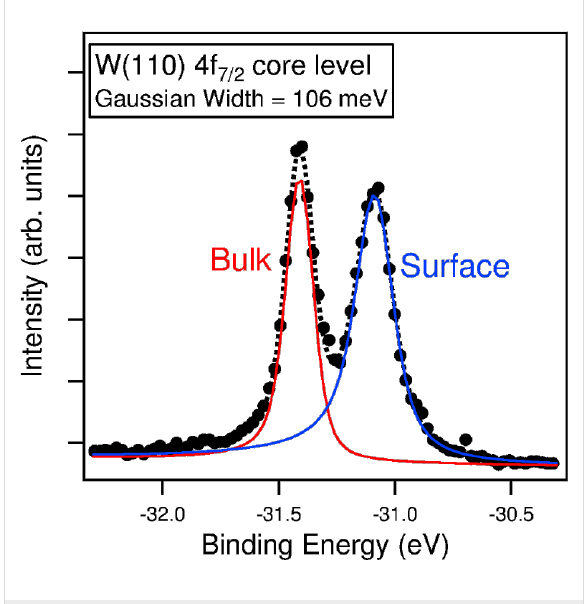
Figure 6: Tungsten 4f 7/2 core level spectrum from a clean W(110) surface acquired in dispersive plane mode. The photon energy is 90 eV. The acquisition time is 80 s. The Lorentzian broadening for the bulk peak was fixed at 60 meV, with an asymmetry parameter of 0.035. The contrast aperture, which acts as the analyzer entrance slit, is 20 μ